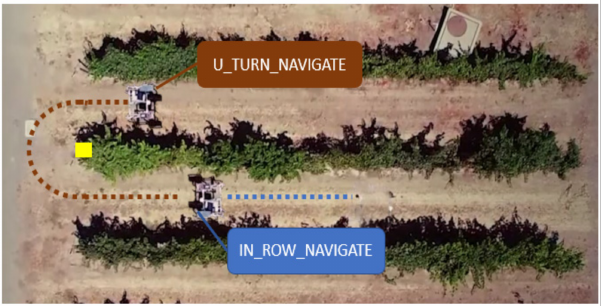
Figure 6. Waypoints generated in different states. The blue points are generated in the “IN_ROW _NAVIGATE” state. The red points are generated in the “U_TURN_NAVIGATE”